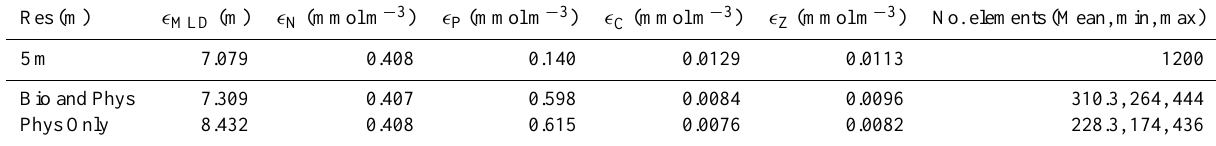
Table 6. The rms error, (cid:15) , of adaptive mesh simulations compared to the simulation with 2.5m vertical resolution at Bermuda. (cid:15) is shown for MLD, and the L2 norm of nutrient, primary productivity, chlorophyll and zooplankton. Note that the PAR and Bio only simulations failed and recorded no result. See Fig. 7 also.